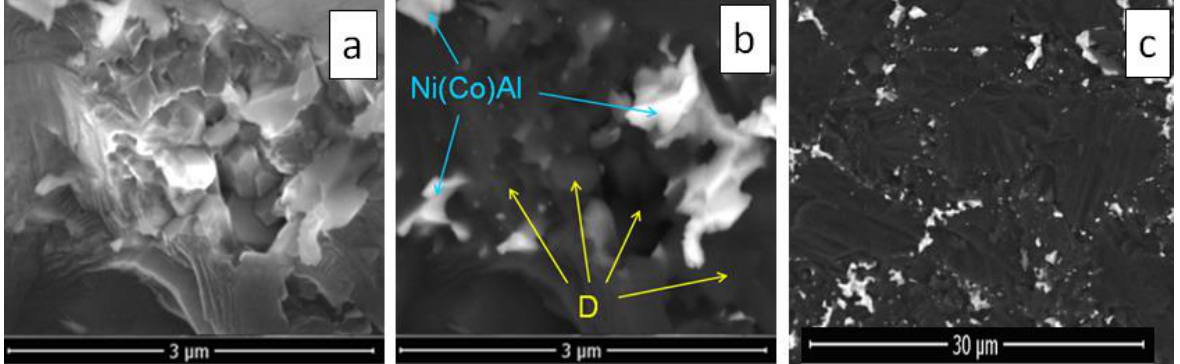
Figure 5. SEM images of a composite obtained by infiltration of nickel into a mixture of FDM-2Al- 6Co at 8 GPa and 1600 °C. Submicron diamonds and AlNi x Co 1 − x intermetallic compound located between micron diamond particles: ( a ) image in reflected electrons; ( b ) the same image in phase contrast mode; and ( c ) fracture surface in phase contrast mode.